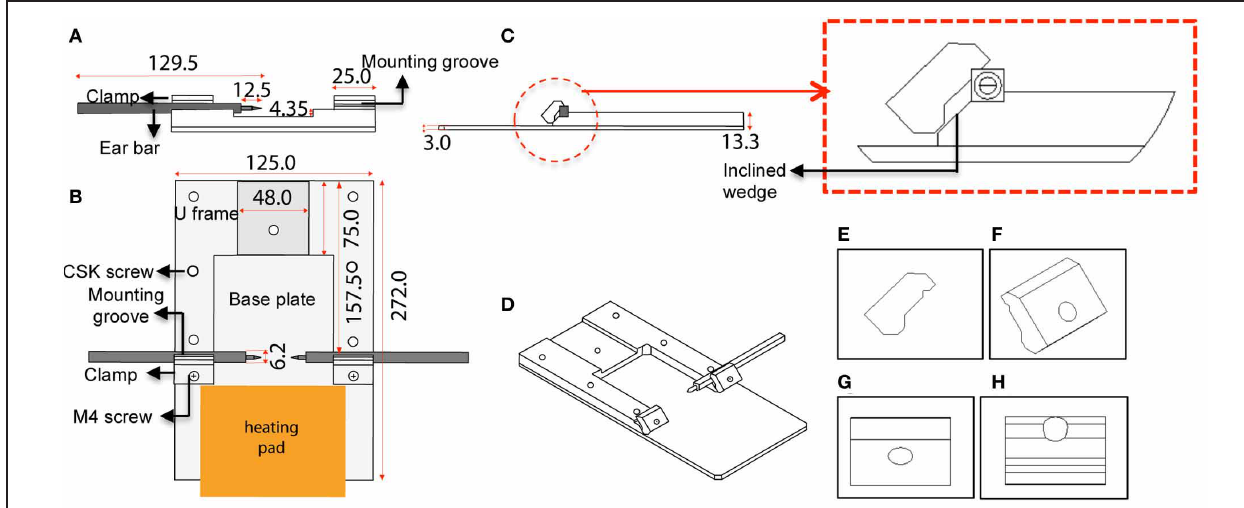
FIGURE 1 | Schematic diagram and dimensions of the custom-designed stereotaxic frame used in the 2P-IBI model. (A) Section view. Cross section view shows the mounting groove engaged with an ear bar. (B) Top view. Position of the heavy base plate, U frame, 2 clamps, 6 CSK screws as well as the 2 M4 screws are shown. Position of the heating pad is depicted. (C) Side view. Thickness of the base plate and U frame are shown. Red circle